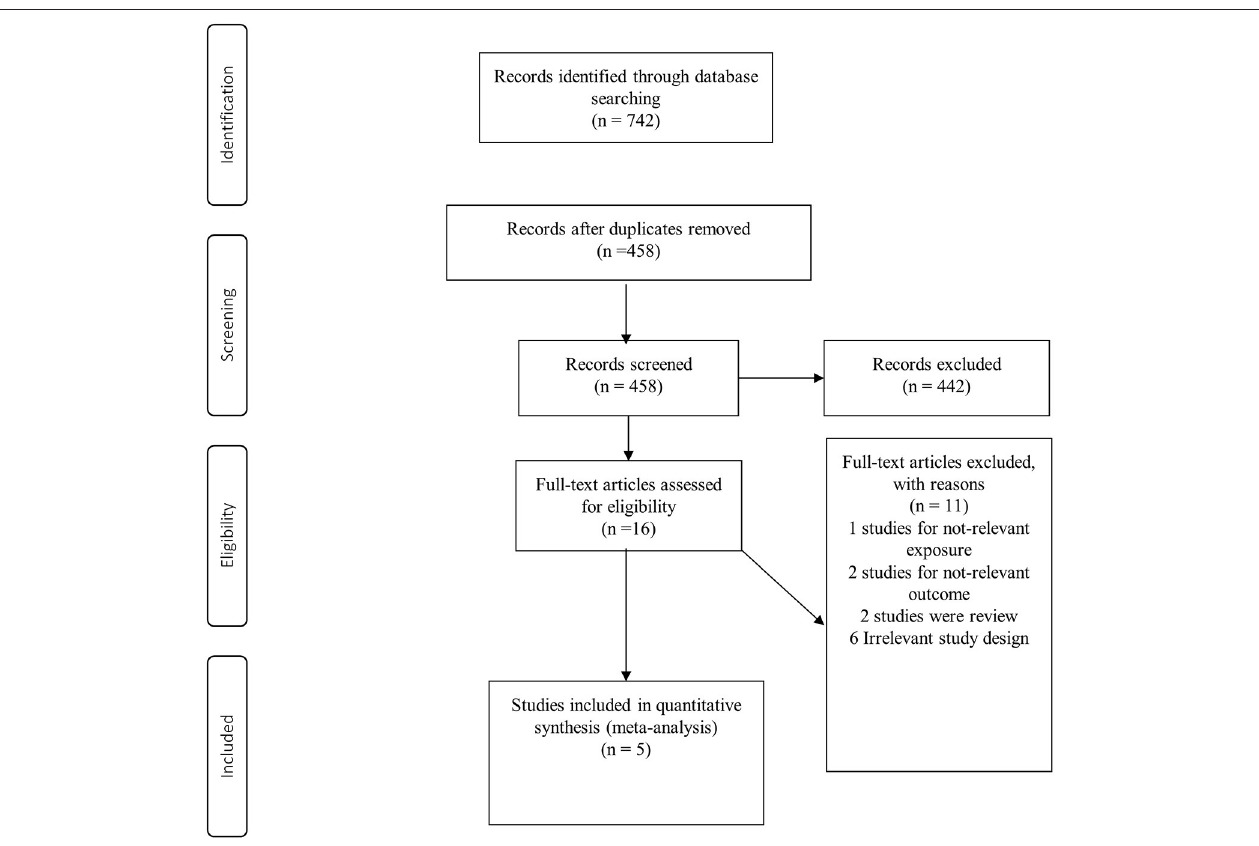
FIGURE 1 | Study selection